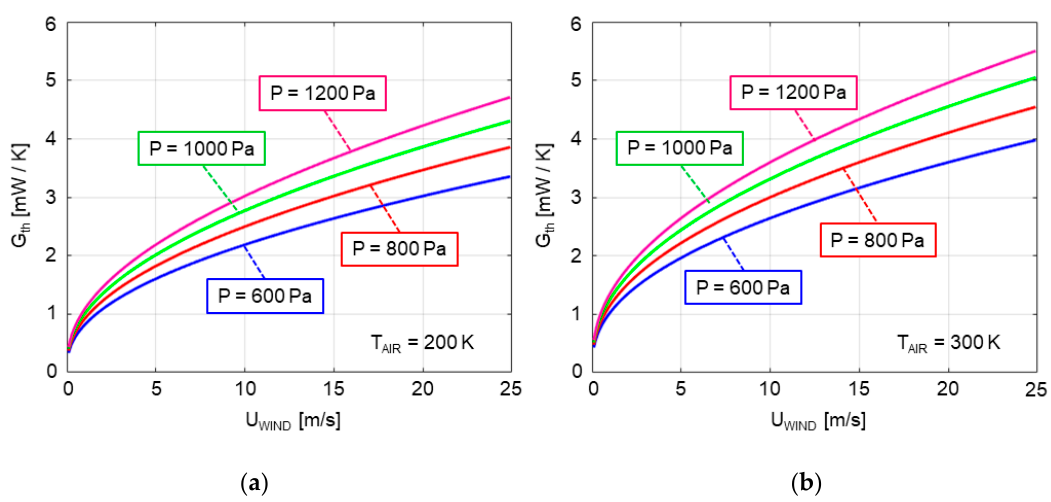
Figure 2. Results of the analytical model developed illustrating the relationship between the overall convective heat transfer coefficient of the sphere and the wind velocity in CO 2 atmosphere, for two temperatures, 200 K ( a ) and 300 K ( b ), and four different values of pressure.